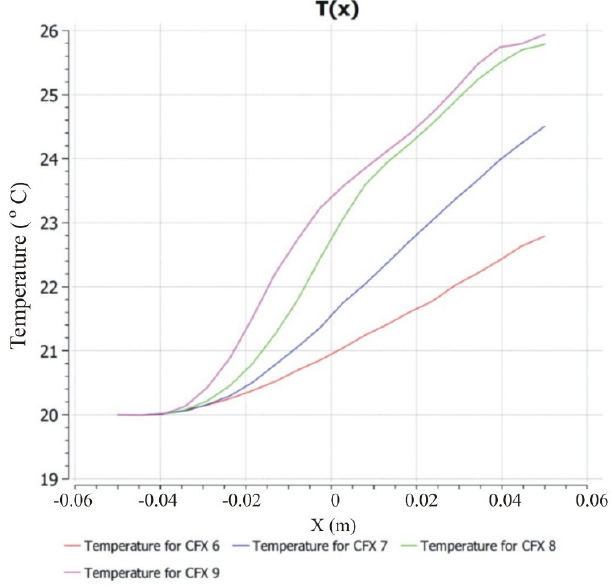
Figure 16. Temperature change graph: red—height 1 mm; blue—height 1.5 mm; green—height 2 mm; purple—height 2.5 mm.